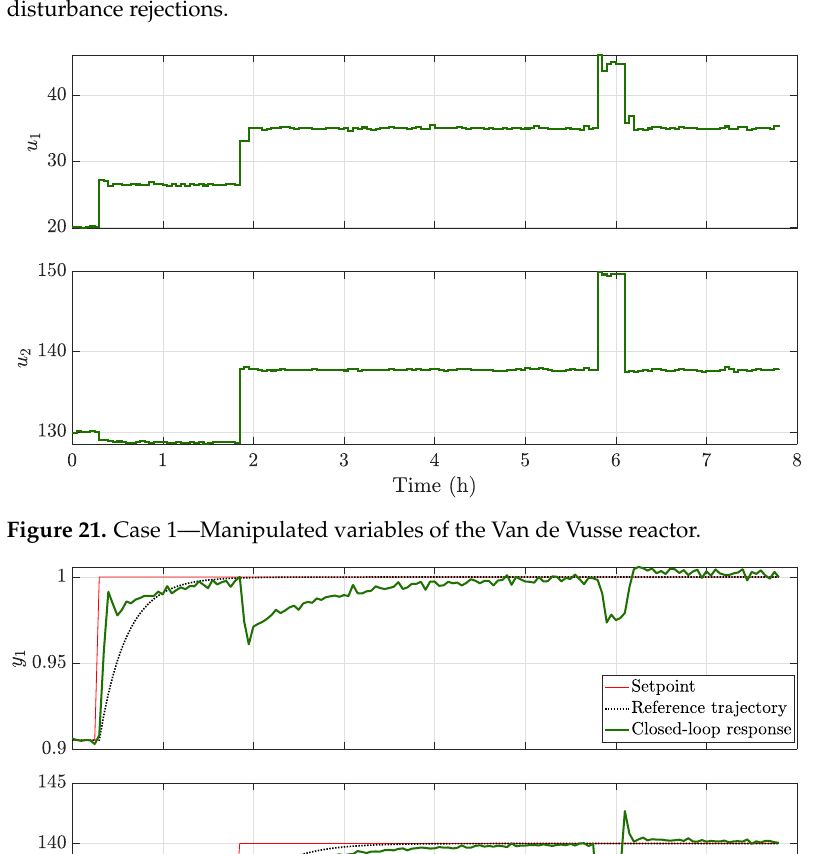
Figure 20. Case 1—Response of the outputs of the Van de Vusse reactor to setpoint changes and disturbance rejections.